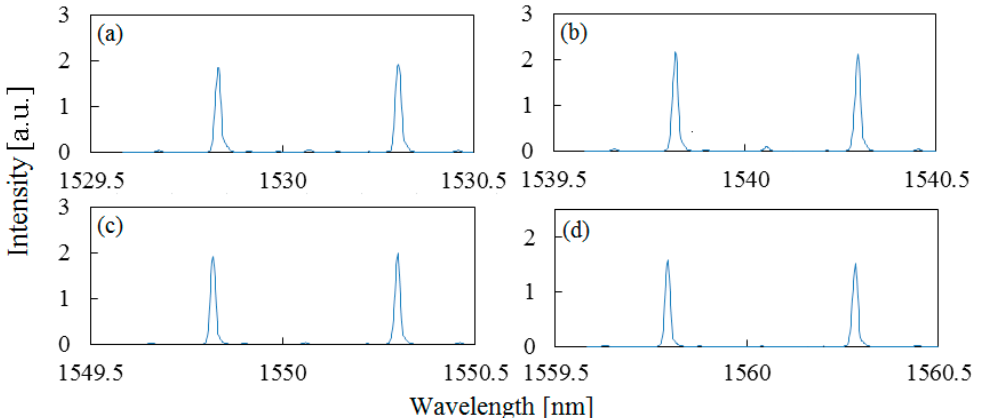
Figure 10. Optical spectra of 60-GHz separation OTT signals generated from the setup where the bias voltages of the MZM were fixed at its null point for the wavelength of 1550 nm. Wavelengths of seed lightwave were adjusted to ( a ) 1530.06 nm, ( b ) 1540.05 nm, ( c ) 1550.05 nm, and ( d ) 1560.04 nm, respectively.